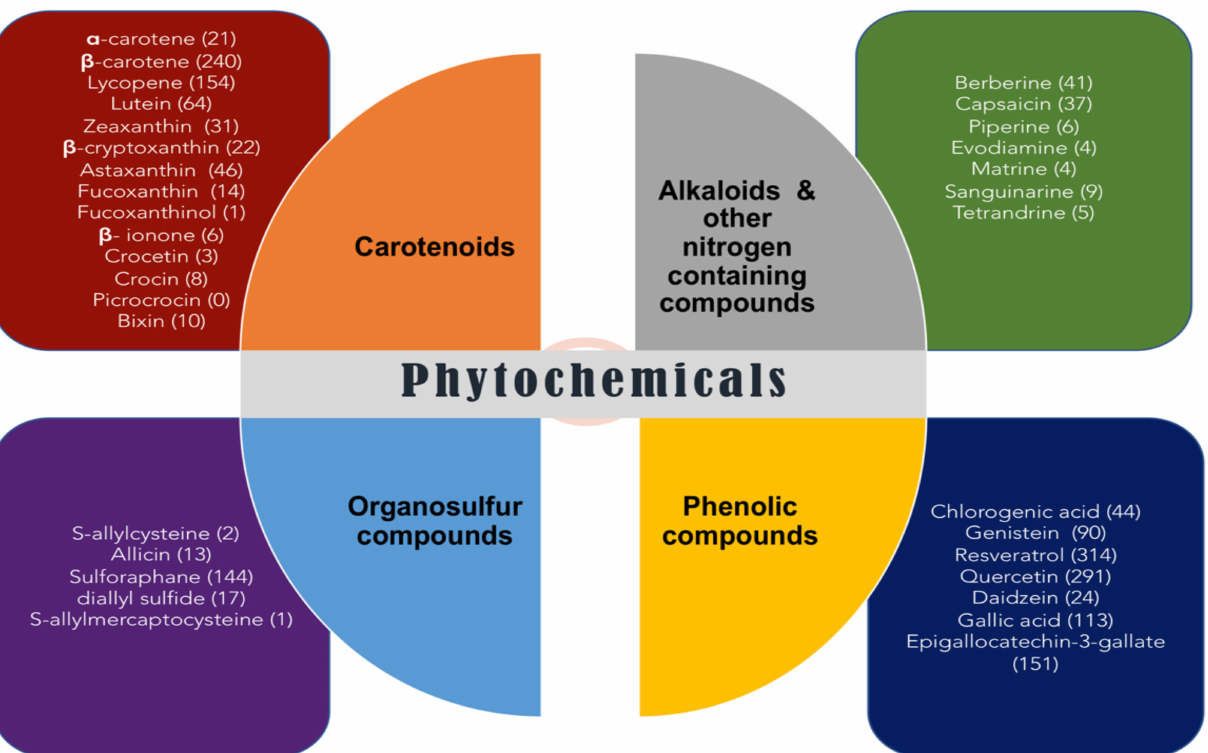
Figure 2. Illustration of the most reviewed antioxidant phytochemicals associated with oxidative stress and cancer. The structure of published literature is based on the citations in PubMed (April 2021). The numbers of published manuscripts are provided in parentheses along with the name of each phytochemical and “oxidative stress and cancer”, within title/abstract, is